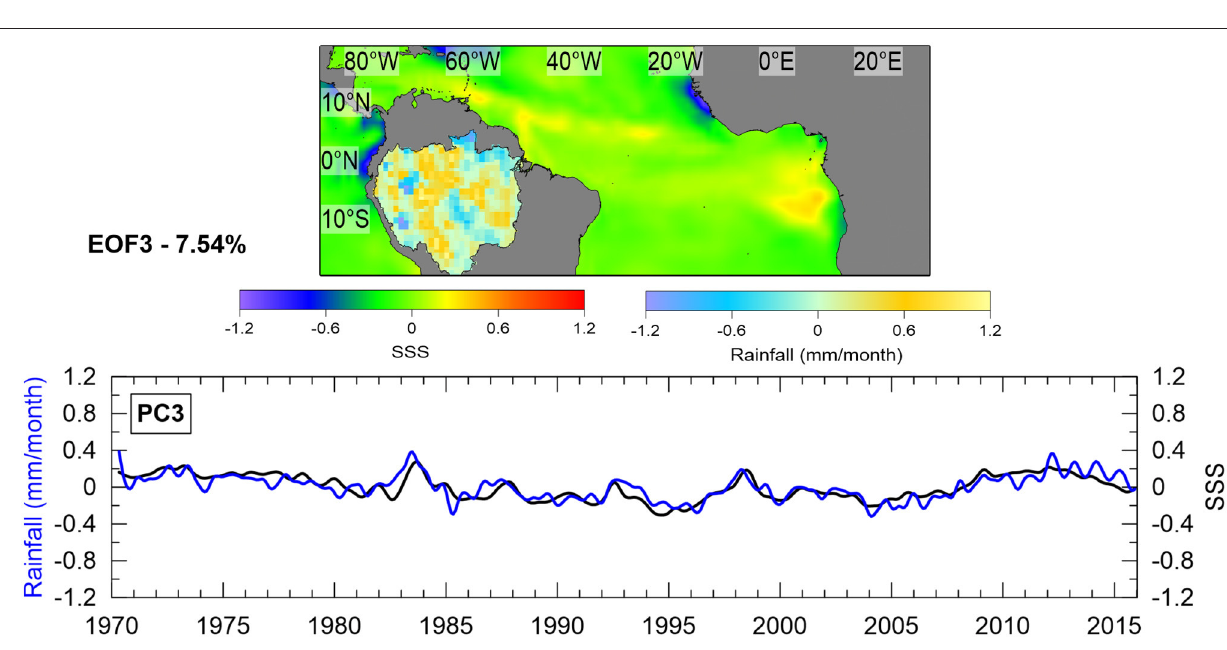
Frontiers in Marine Science |